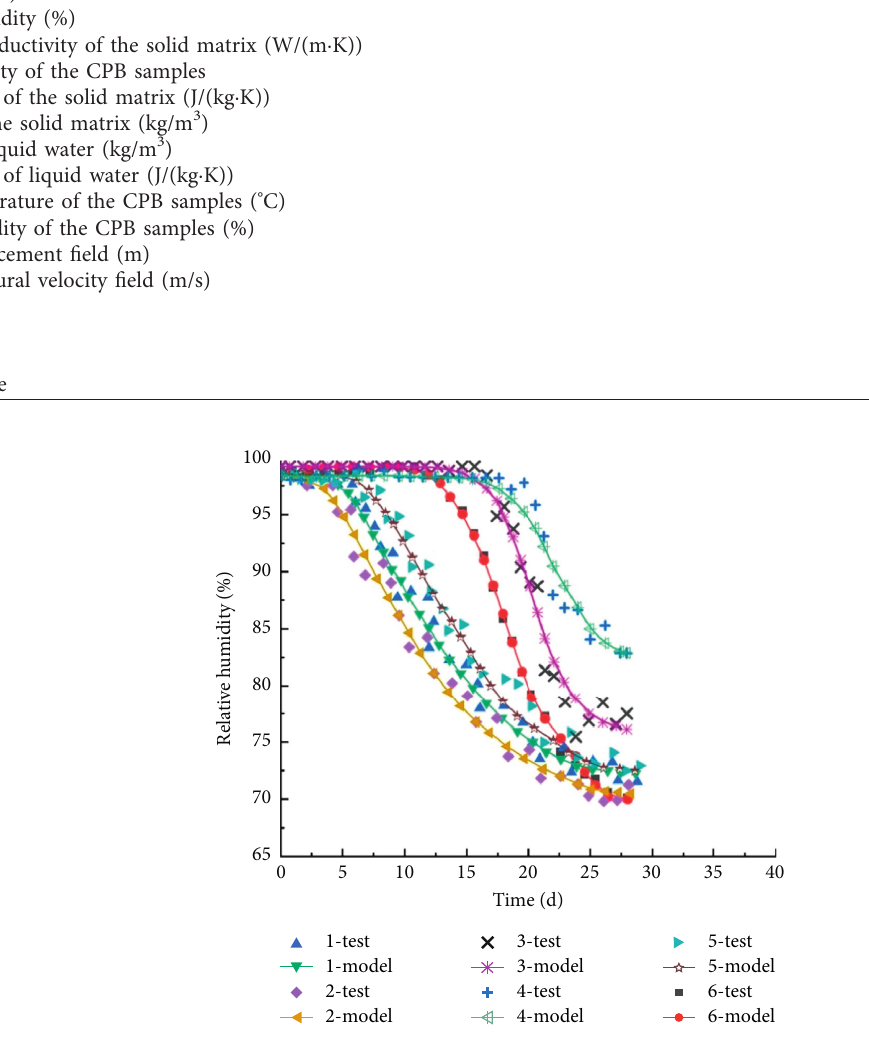
Figure 6: Comparison between predicting and testing results of internal relative humidity of